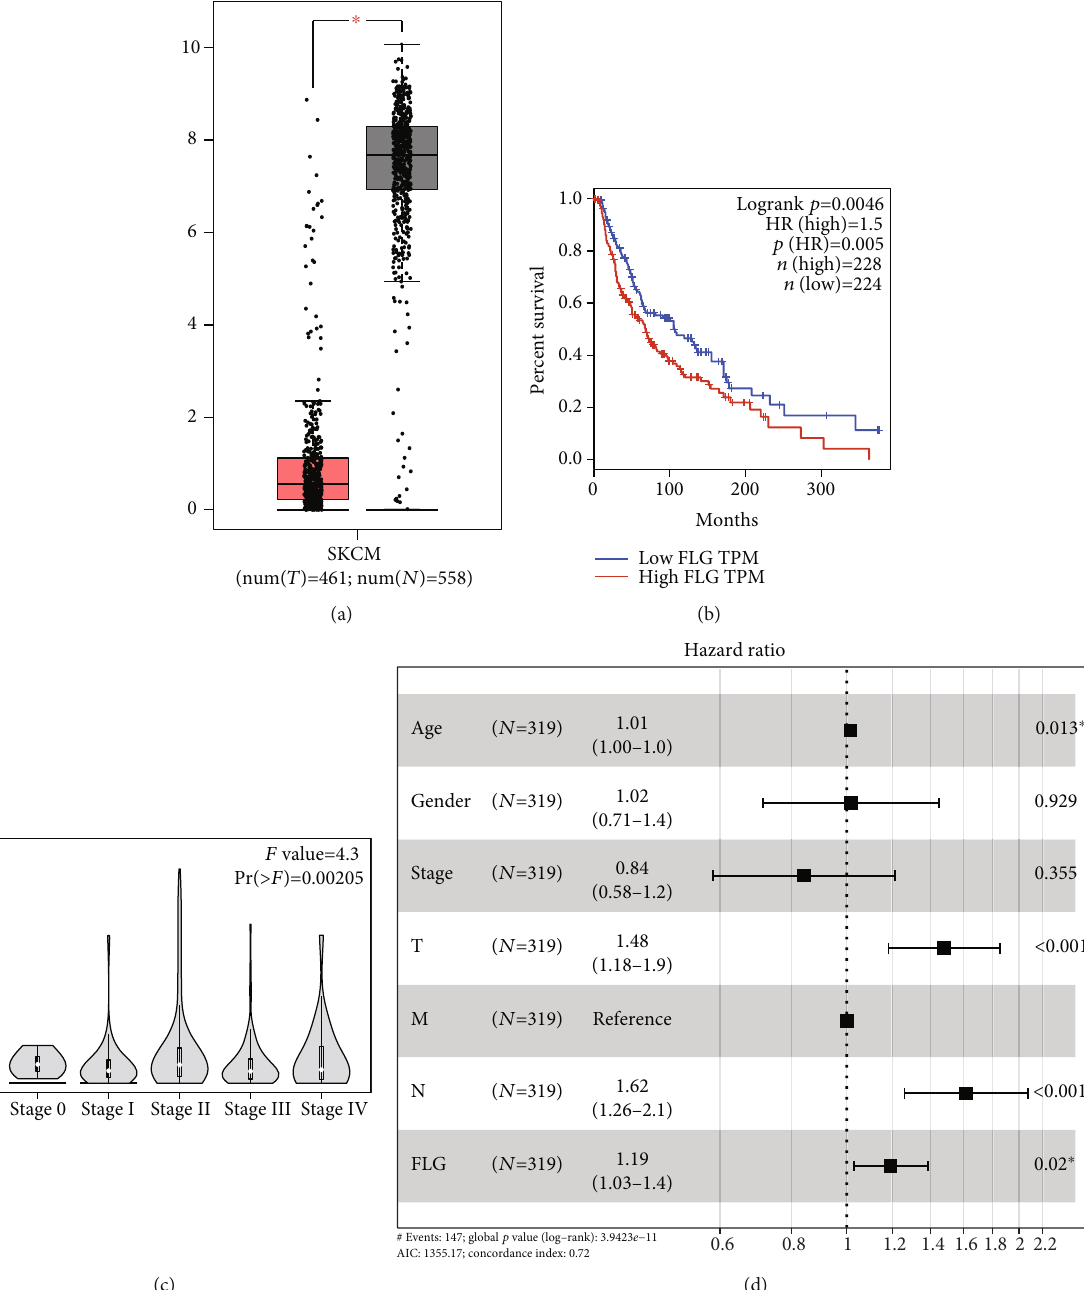
Figure 3: Survival outcome, expression di ff erence analyzed by GEPIA, and multivariate Cox analysis of FLG: (a) di ff erential expression of FLG in di ff erent disease state (tumor and normal); (b) survival curve of di ff erential FLG expression; (c) di ff erential expression of FLG in di ff erent pathological stages; (d) the expression of FLG and multivariate Cox analysis of clinicopathological